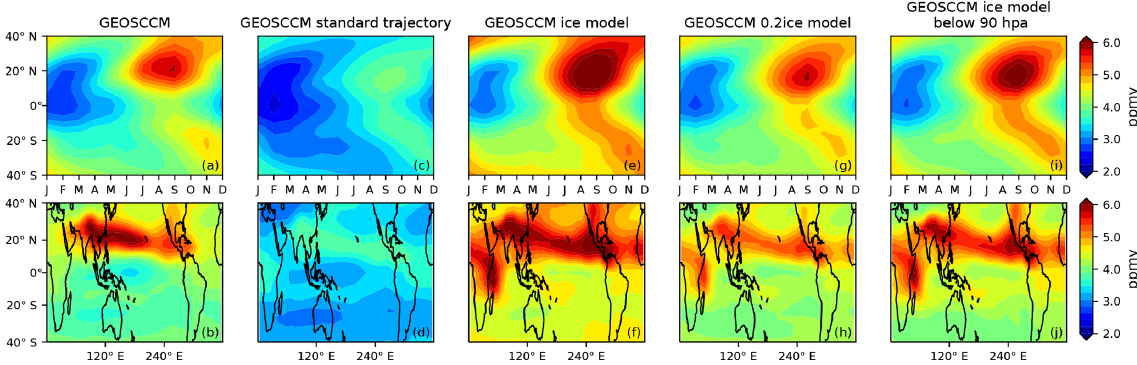
Figure 5. Top panels: zonal mean seasonal cycle of 100hPa water vapor (ppmv) between 40 ◦ S and 40 ◦ N from the (a) GEOSCCM, (c) GEOSCCM standard model, (e) GEOSCCM ice model, (g) GEOSCCM 0.2ice model, and (i) GEOSCCM ice model with ice below 90hPa. Bottom panels: JJA 100hPa water vapor (ppmv) between 40 ◦ S and 40 ◦ N from the (b) GEOSCCM, (d) GEOSCCM standard model, (f) GEOSCCM ice model, (h) GEOSCCM 0.2ice model, and (j) GEOSCCM ice model with ice below 90hPa.